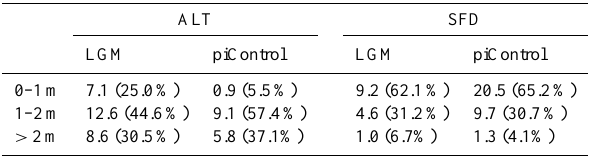
Table 3. Global areas (in million km 2 ) for maximum active layer thickness (ALT) and maximum seasonal frost depth (SFD). Per- centage for ALT relative to the total permafrost regions, and that of SFD relative to the total seasonally frozen ground regions are given in